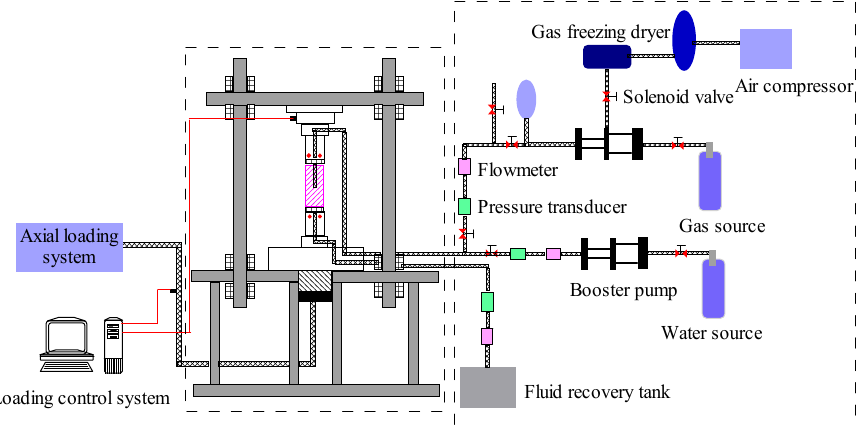
Figure 3 . Schematic diagram of the nitrogen fracturing test system.